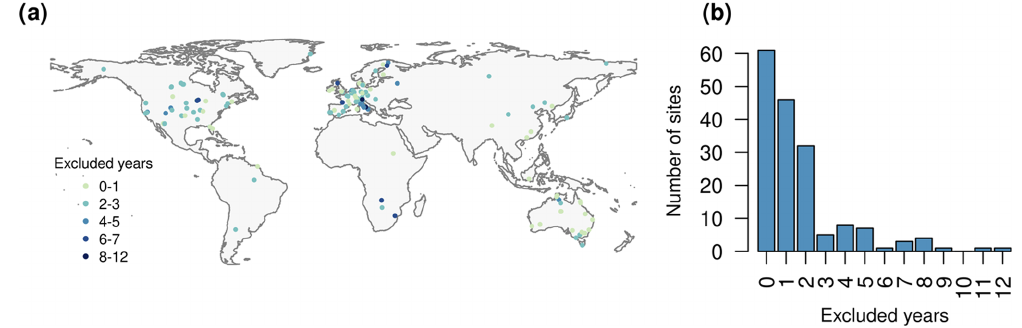
Figure 4. Excluded years from selected sites. (a) A map of selected sites showing the number of excluded years. (b) A histogram of excluded site